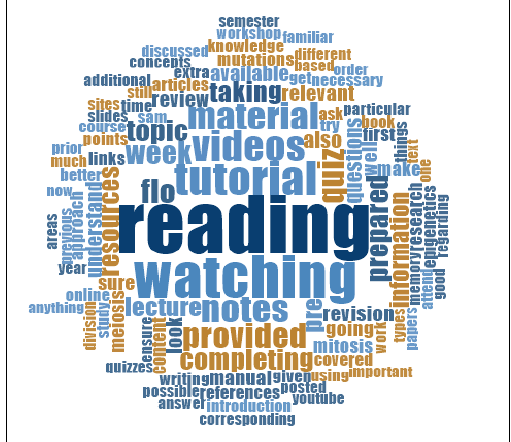
Figure 1: Text analysis of student responses in weeks one and two to the reflection question ‘What is your approach to preparing for the tutorial this week’. 328 student responses were used in the